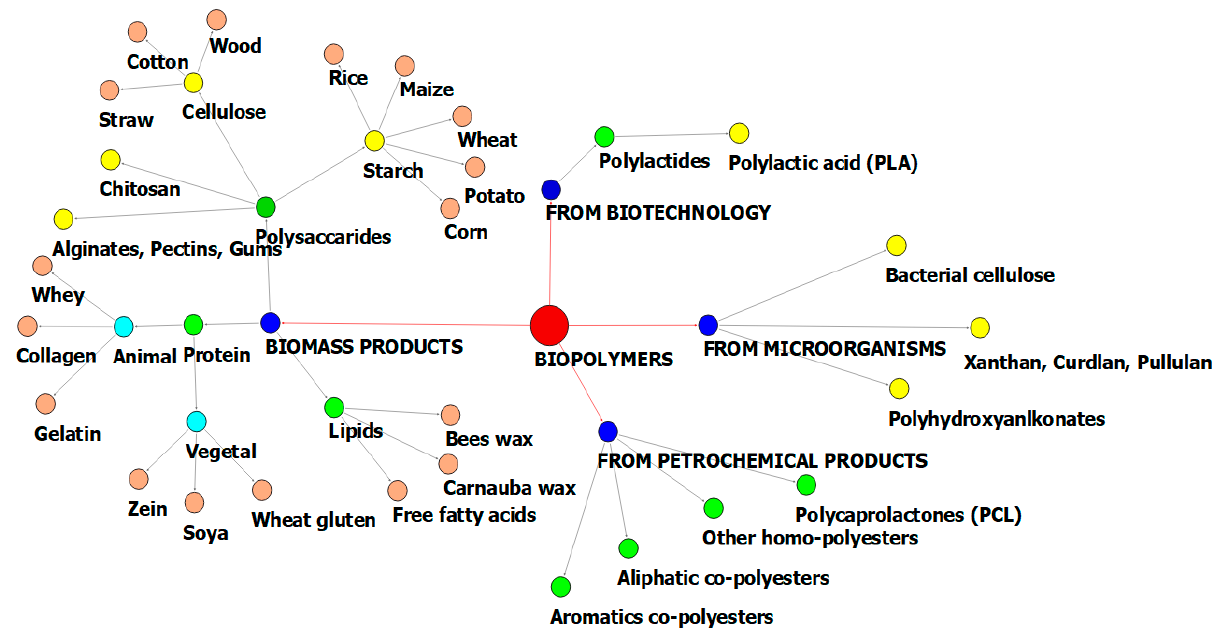
Figure 1. A social network graphical illustration of biopolymers classification .